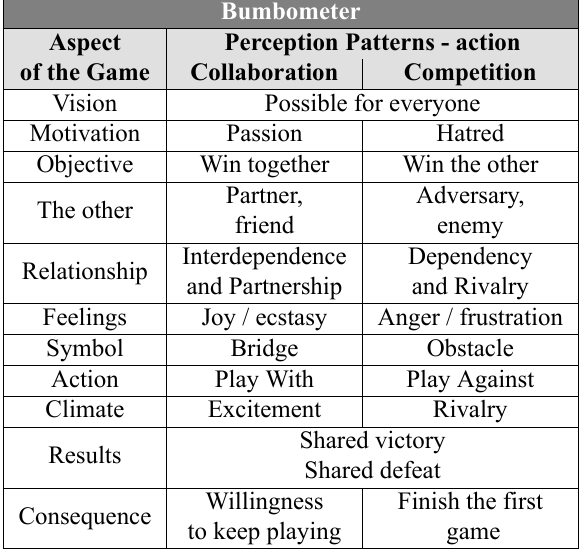
Table 3. Summary table of aspects that characterize the Bumbome­ ter